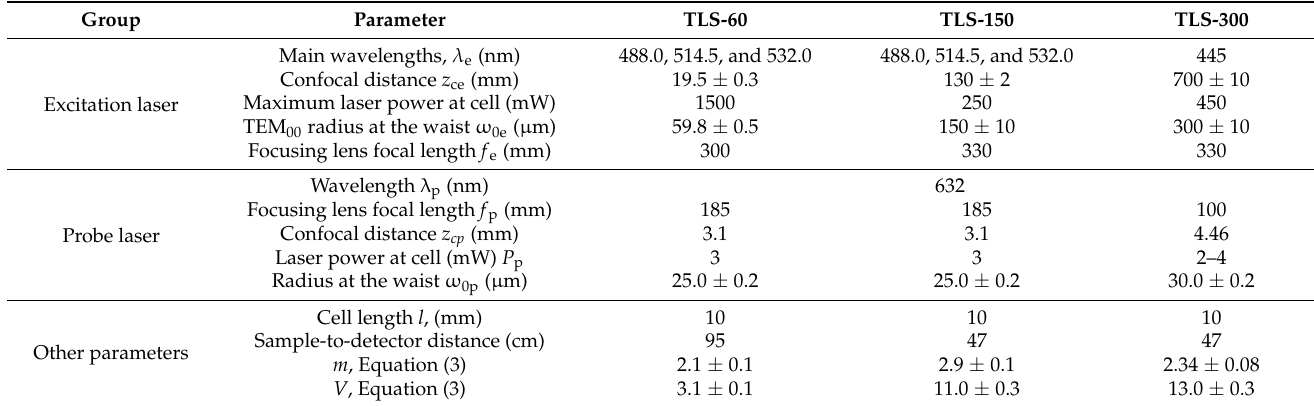
Table 1. Parameters of the optical-scheme configuration of dual-beam thermal-lens